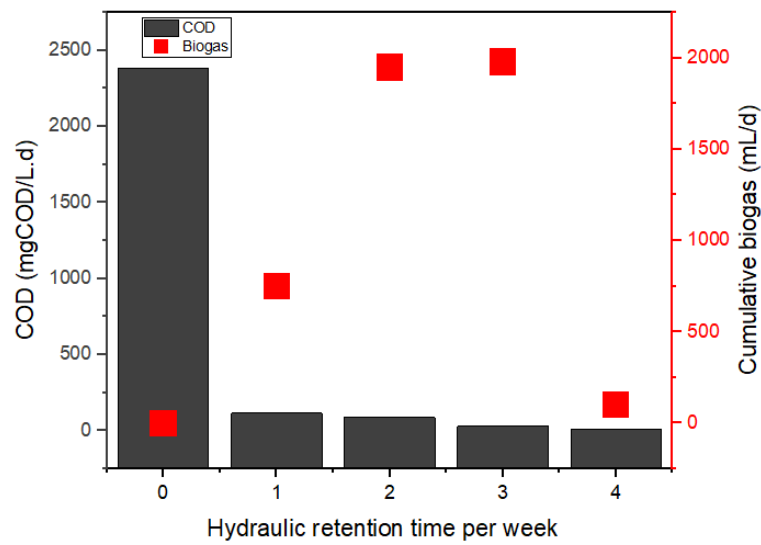
Figure 3. Weekly reduction of the COD and biogas produced by the BP system.